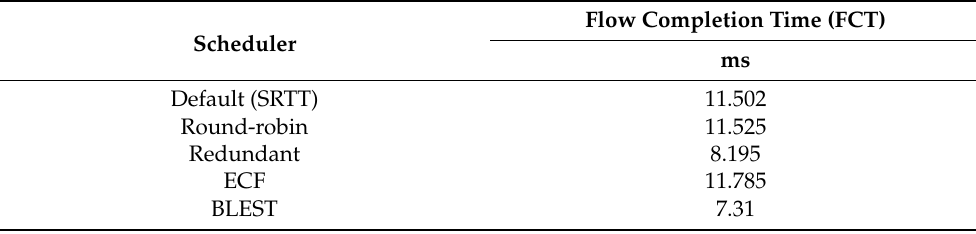
Table 3. Performance of the tested MPTCP schedulers in terms of FCT for OLIA as a CCA.